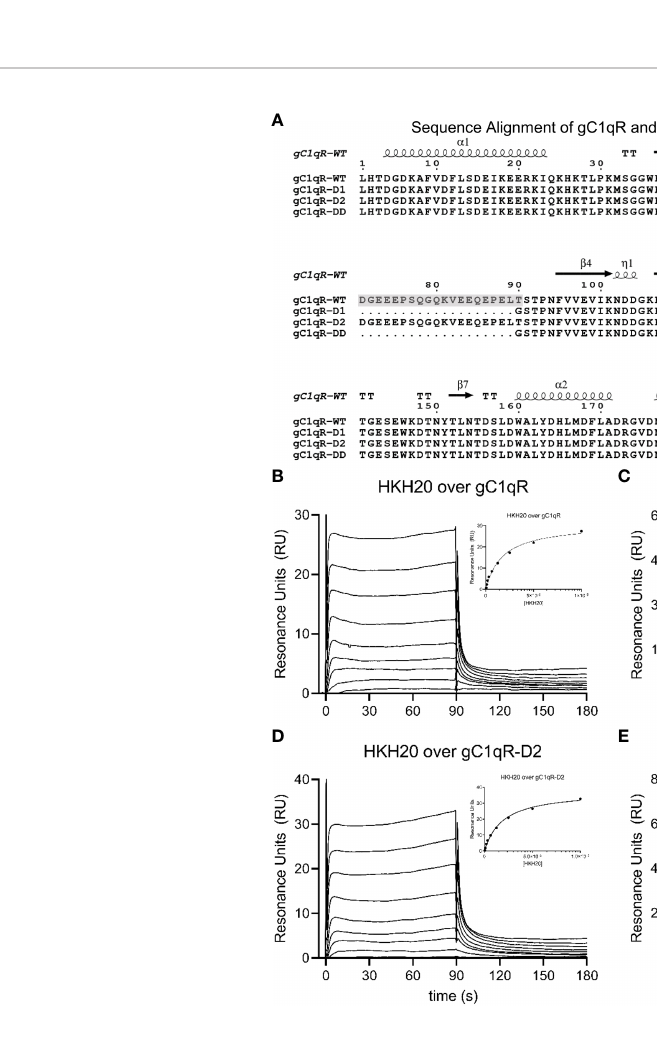
FIGURE 1 | Generation and Characterization of a Panel of Loop-deletion Mutants in gC1qR. (A) Sequence/structure alignment of the mature form of wild-type gC1qR and three deletion mutants wherein either one or both negatively charged loops have been replaced by a short glycine linker. The locations of secondary structure elements, as seen in the crystal structure of wild-type gC1qR (9), are shown above the alignment. Transparent grey boxes highlight the locations of the fi rst and second acidic loops in the wild-type gC1qR sequence. Please note that the fi rst residue in this alignment corresponds to Leu 74 in the human gC1qR sequence. (B) Surface plasmon resonance characterization of the interaction between wild-type gC1qR and peptide HKH-20 derived from human high-molecular weight kininogen. Reference-corrected sensorgrams for a two-fold dilution series of HKH-20 peptide (10 mM highest concentration) injected over a surface of immobilized gC1qR. A plot where SPR response immediately prior to injection stop is shown as a function of HKH-20 concentration is inset. Data shown in this panel were modi fi ed from Ghebrehiwet et al. (1) (C) Surface plasmon resonance characterization of the interaction between mutant gC1qR-D1 and peptide HKH-20. (D) Surface plasmon resonance characterization of the interaction between mutant gC1qR-D2 and peptide HKH-20. (E) Surface plasmon resonance characterization of the interaction between mutant gC1qR-DD and peptide